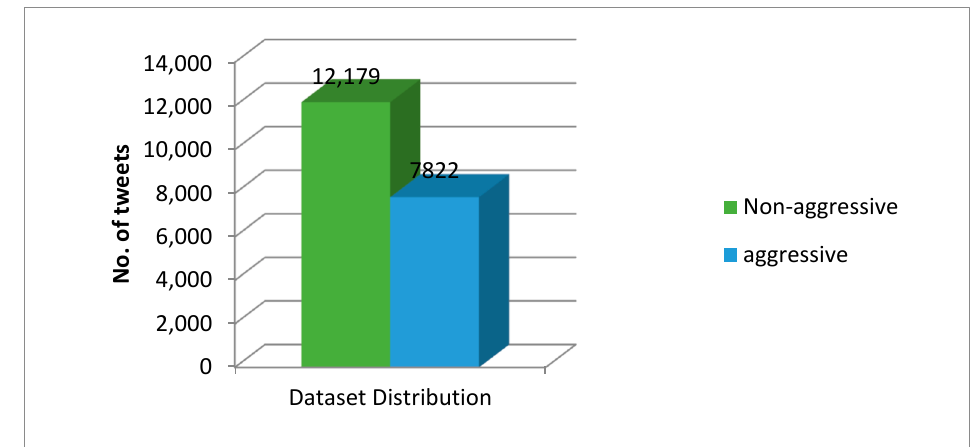
Figure 6. Dataset Distribution.